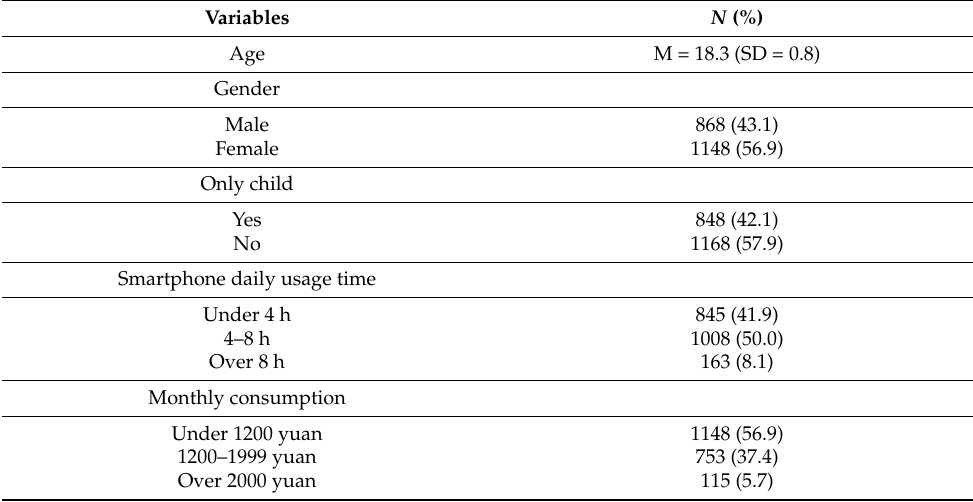
Table 1. Demographic characteristics of participants ( n =